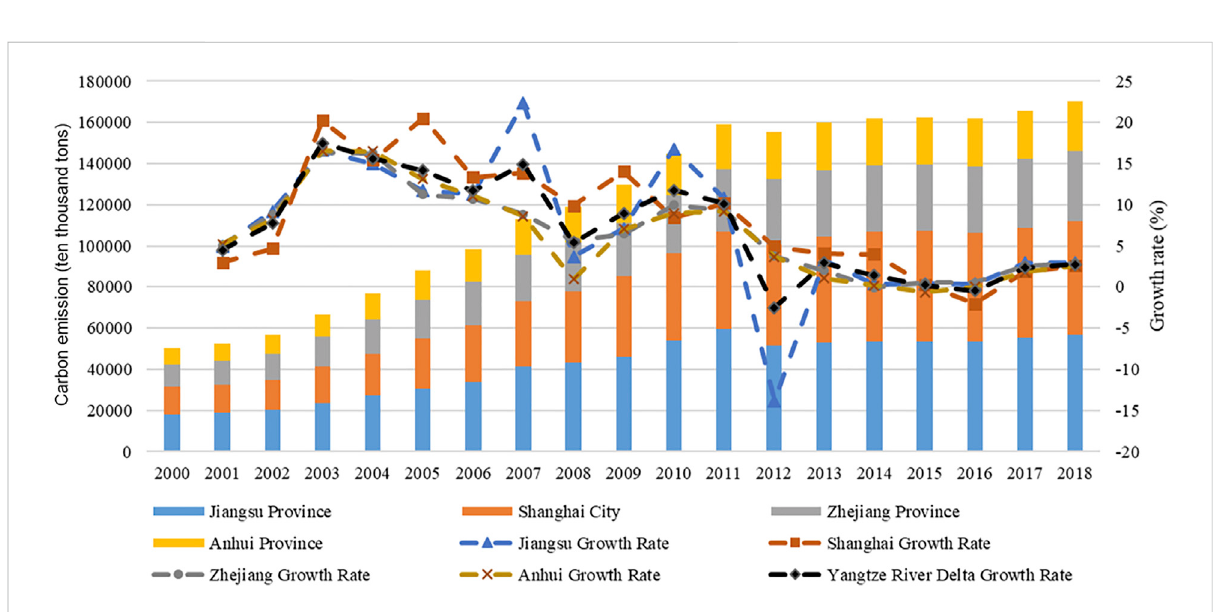
FIGURE 3 Trends in the evolution of carbon emissions in the Yangtze River Delta, 2000 –